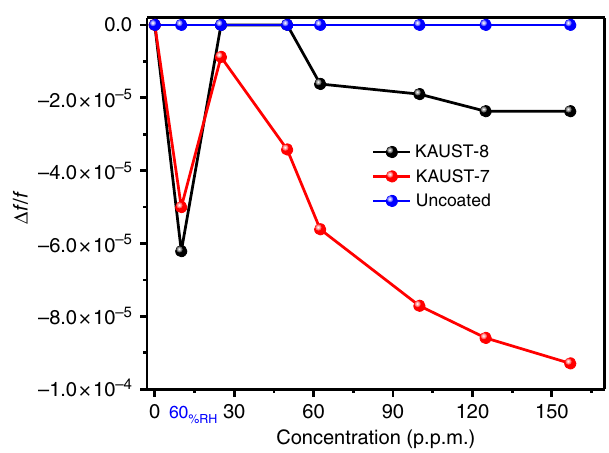
Fig. 7 Sensor responses. Plots of sensors responses as a function of SO 2 concentration in synthetic air